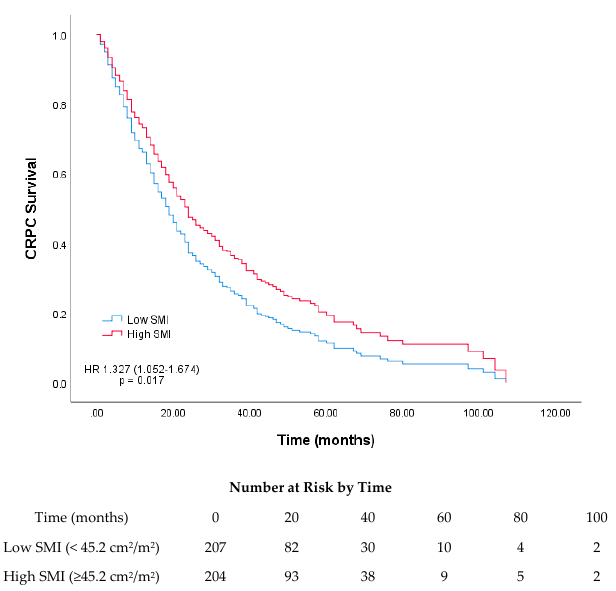
Figure 1. Survival curves based on Cox regression analysis of the survival of patients with castration-resistant prostate cancer (CRPC) stratified according to their median skeletal muscle index (SMI; cm 2 /m 2 ).